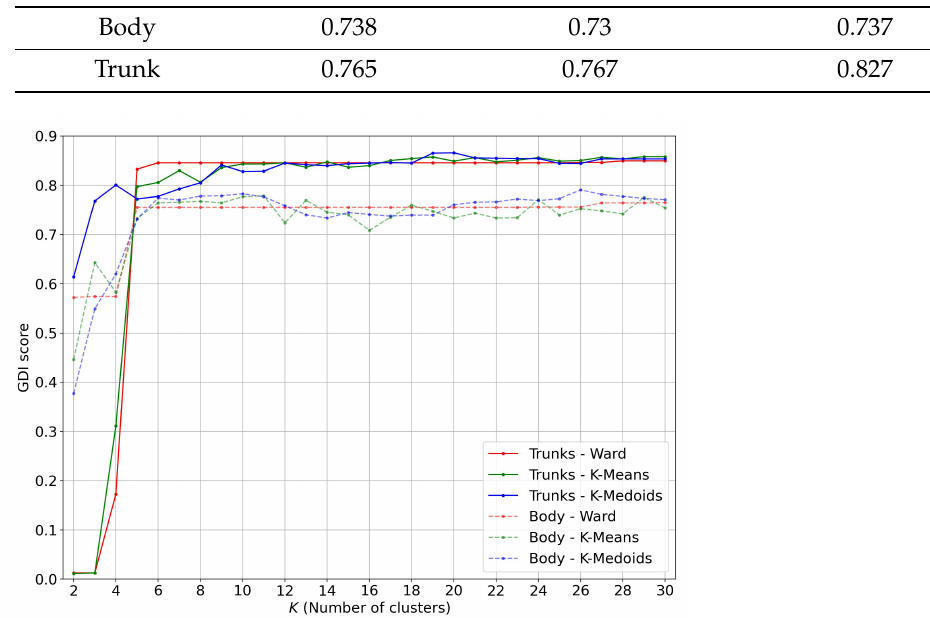
Figure 17. Comparison of GDI score on the persistence silhouettes of the whole body and the trunk.